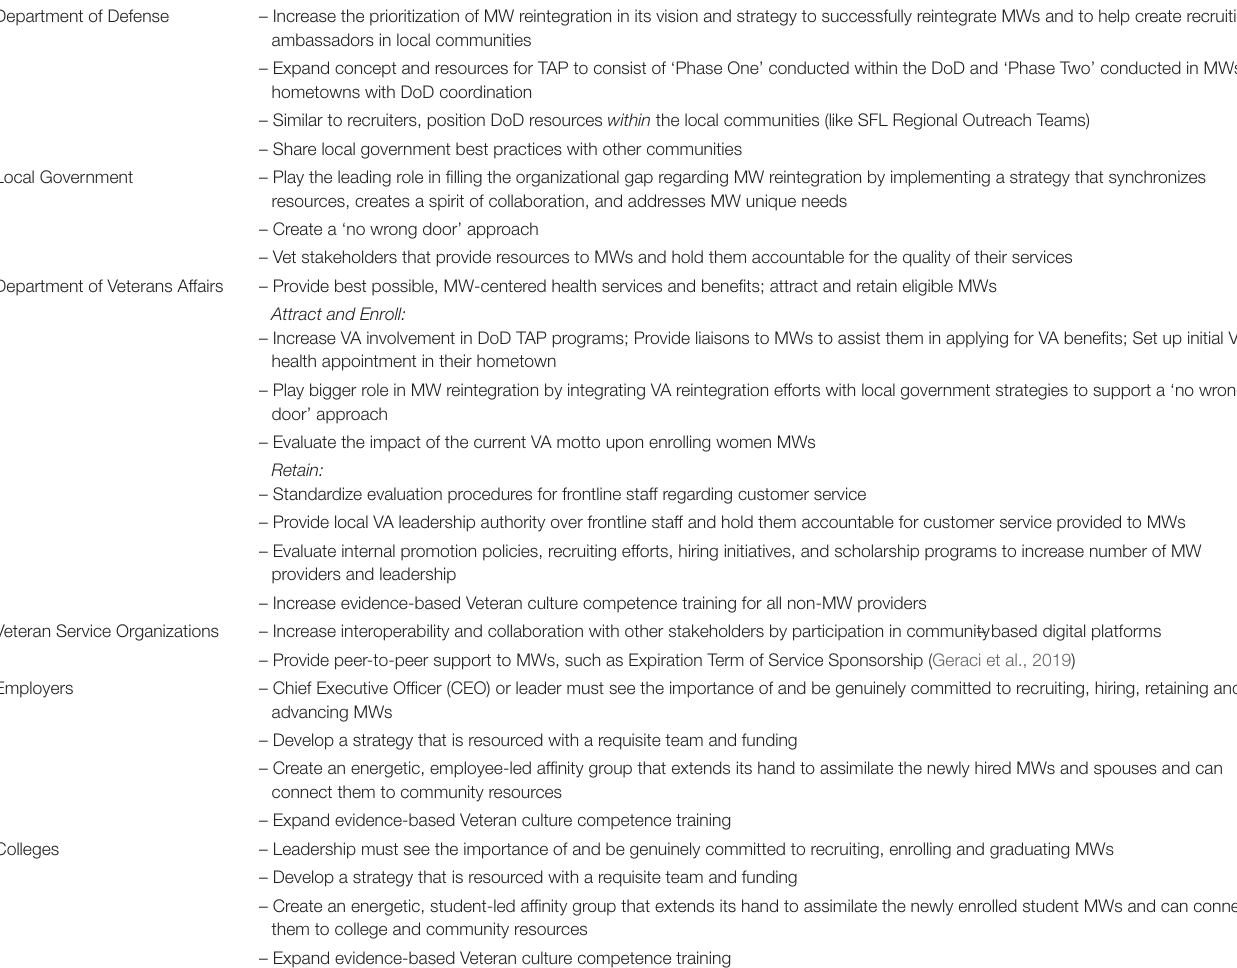
TABLE 1 | Expanded roles and recommendations to better reintegrate modern